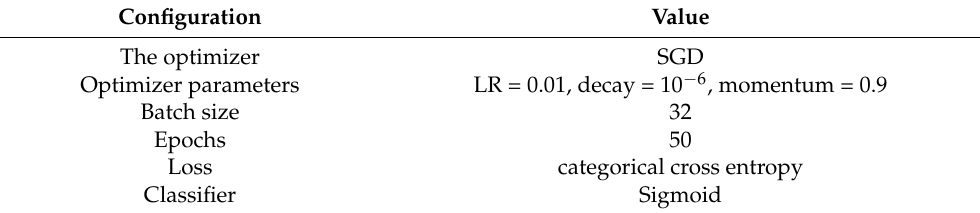
Table 5. The hyper-parameter values of the proposed ML-CNN model.